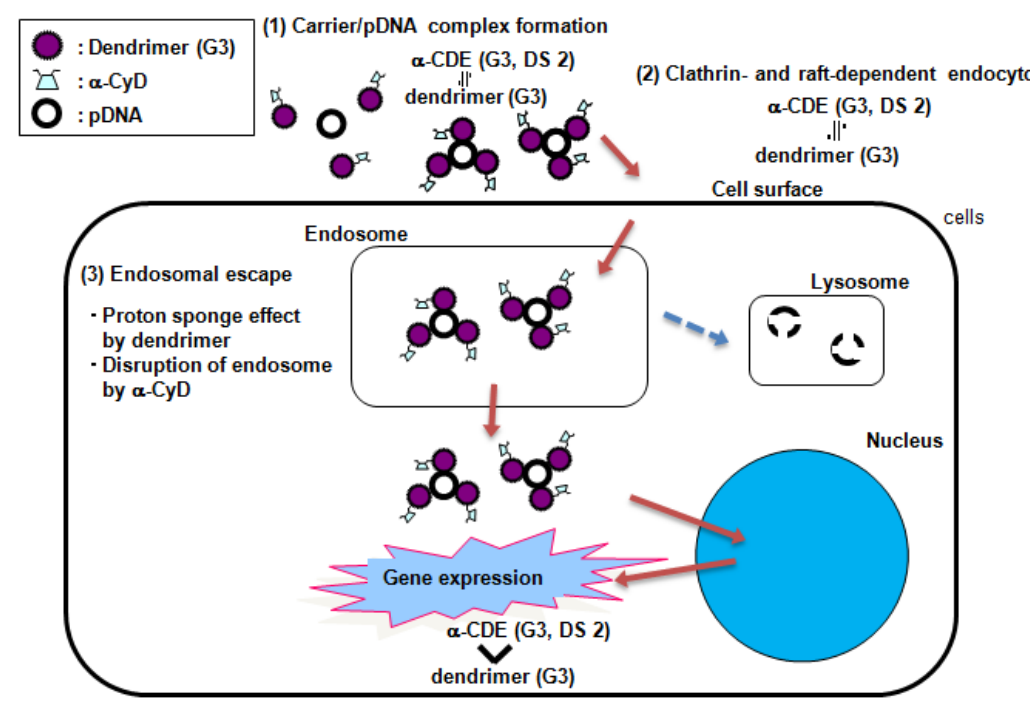
Figure 2. Proposed scheme for improved effects of gene transfer activity by α -CDE (G3, DS